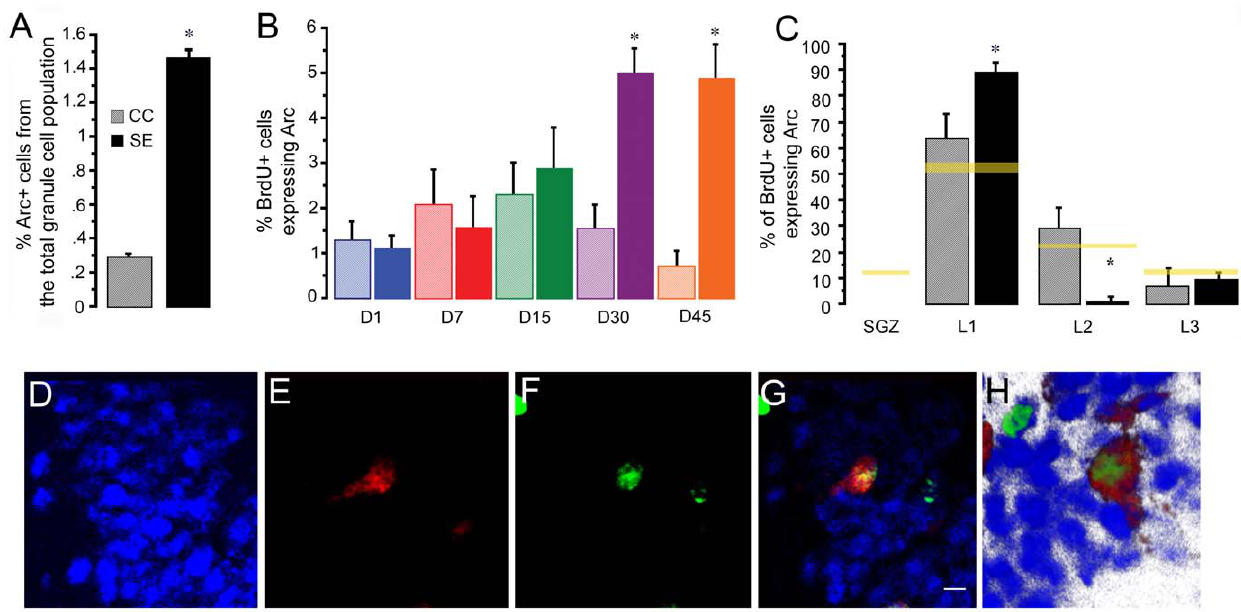
Figure 3. Arc expression after spatial exploration. A) Percentage of the whole granular cell population that expresses Arc after spatial exploration. Note that Arc expression is observed in a higher proportion of cells in the exploration group (solid bar) than in cage controls (pattern bar). *P , 0.001. B) Percentage of BrdU-positive cells that expressed Arc in each PBI group, i.e., sacrificed either directly from its home cage (CC, pattern bar) or after spatial exploration (SE, solid bar). Arc expression in BrdU-positive cells occurs with no behavioral stimulation from day 1 until day 15 PBI, but on days 30 and 45 PBI, Arc expression was observed in significantly more BrdU-positive neurons from exploration animals than from cage controls. *P , 0.01. C) Percentage of BrdU-positive cells expressing Arc in each DG layer, either after cage control conditions (patterned bar) or spatial exploration (solid bar). The yellow horizontal bars represent the proportion of the total BrdU-positive cells found in each layer on days 30 and 45. Note that no Arc expression was found in BrdU-positive neurons in the SGZ. In L1, the IEG Arc was expressed in a larger proportion of new neurons from exploration animals than from the cage controls, *P , 0.01, indicating that BrdU-positive neurons located in L1 are more likely to respond to exploration. The opposite was observed in L2, i.e. the proportion of BrdU-positive cells in L2 that expressed Arc was much lower in SE than in CC animals. D to H) 40 6 confocal images taken from the middle plane of a confocal microscope image stack were used to verify the co-localization of Arc and BrdU. D) NeuN in blue, E) Arc protein in red, F) BrdU in green, G) NeuN, Arc, and BrdU merge; note that BrdU-positive neurons expressing Arc appear yellow. H) Flat image obtained from a 3D boxels reconstruction. The rotation of the 3D projection was used to confirm BrdU and Arc co- localization. The scale bar in G is 100 m